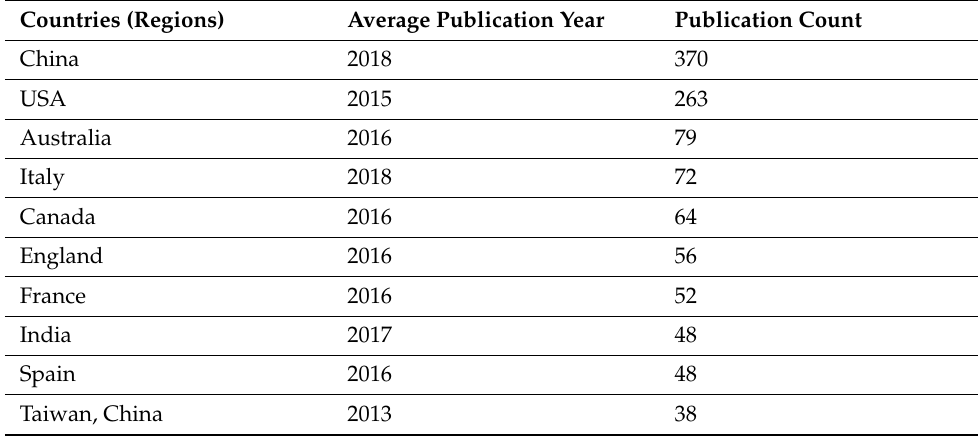
Figure 4. Countries (regions) and timing progress. The “Taiwan” in this figure refers to “Taiwan, China”. Table 2. Distribution and timing progress examples of existing publications. Countries